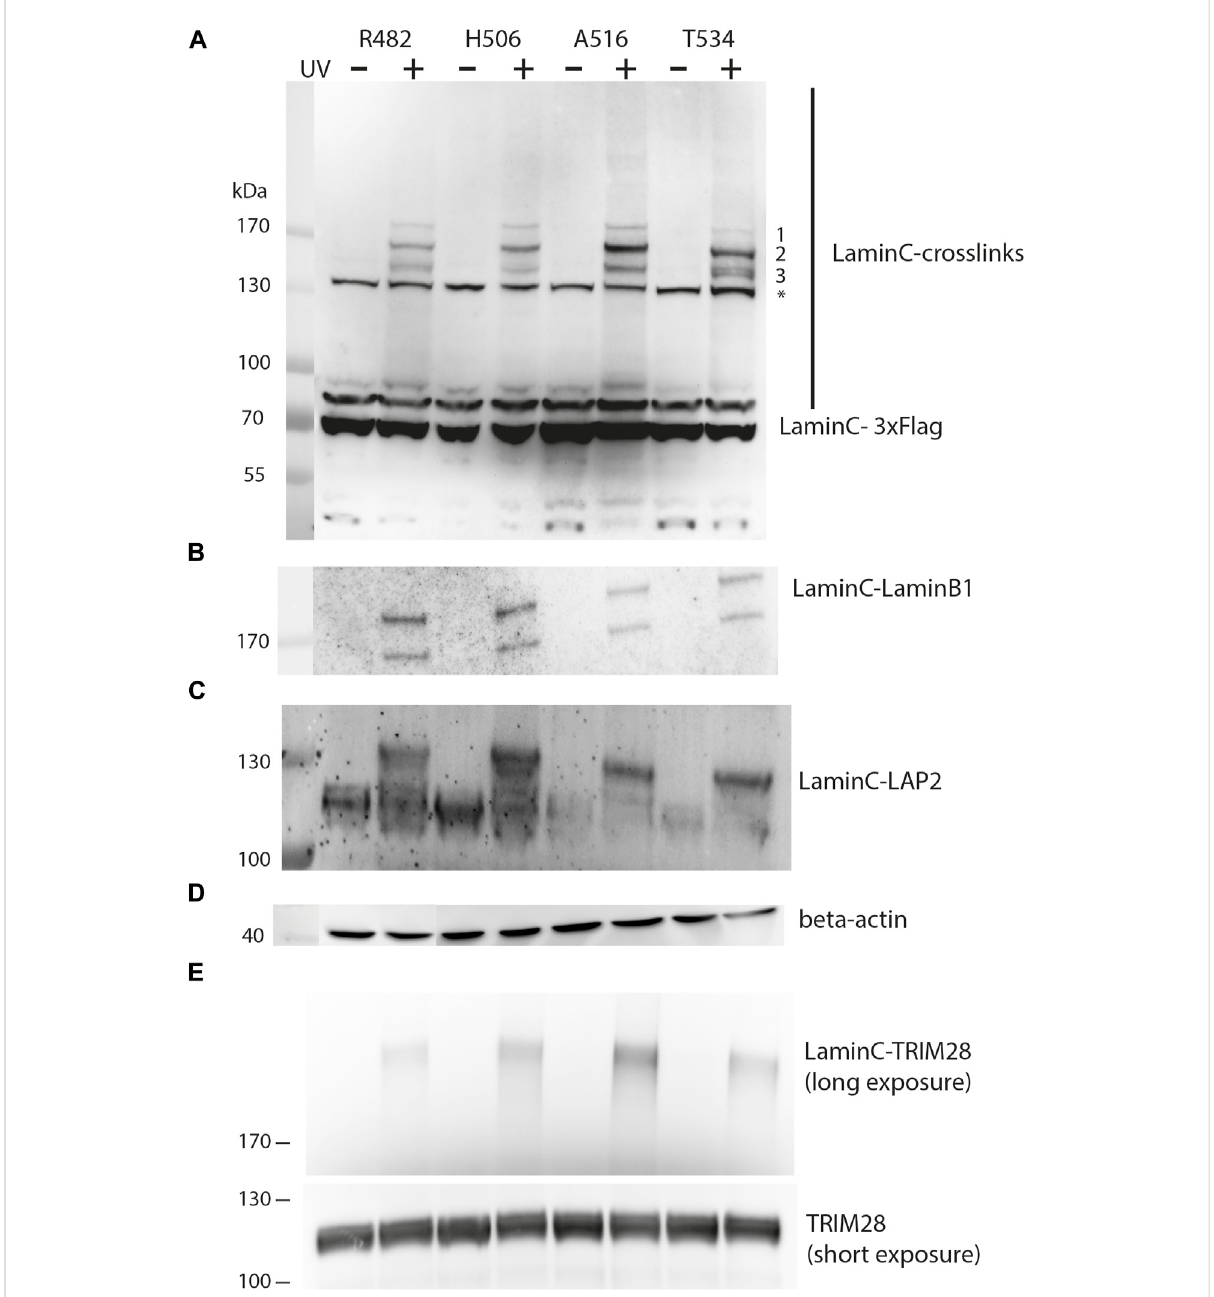
FIGURE 2 UV-dependent crosslinking pattern of individual sites within laminC. HEK293 cells were transiently transfected as described in Figure 1. All cells were cultivated in medium containing pBPA. Cells were exposed to UV 365nm as indicated and lysates analyzed by Western blot using (A) anti-Flag (major crosslink products marked with 1 – 3), (B) anti-laminB1, (C) anti-LAP2, (D) anti- β -actin (loading control) and (E) anti-TRIM28 antibody. The asterisk marks a non-speci fi cally cross-reacting band of the anti-Flag antibodies. Panel (E) was obtained with a different set of samples, therefore regular TRIM28 is shown as a separate loading